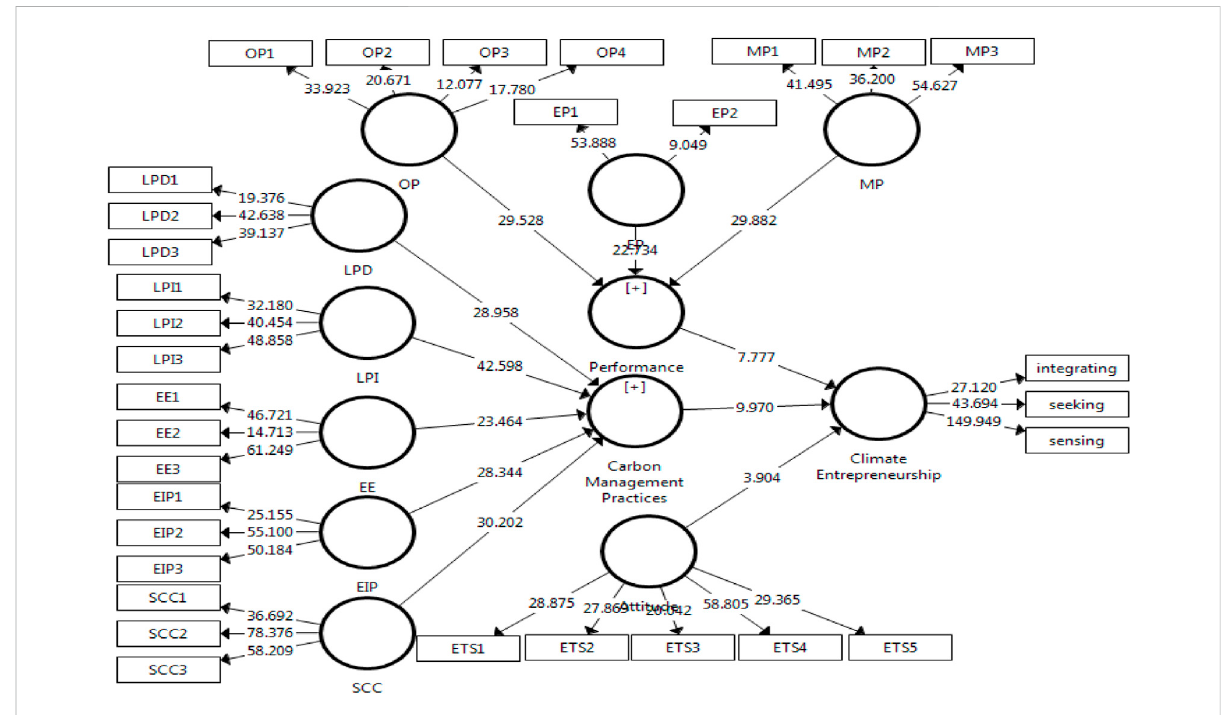
FIGURE 3 Model loadings with the t-values of